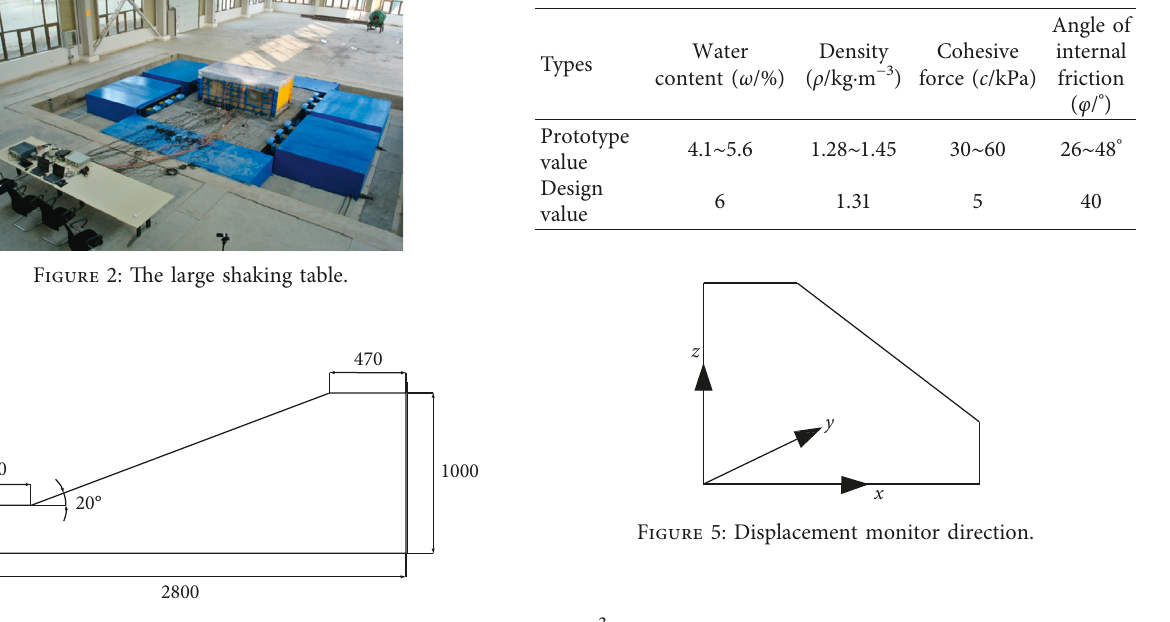
Figure 3: Size of the slope model.